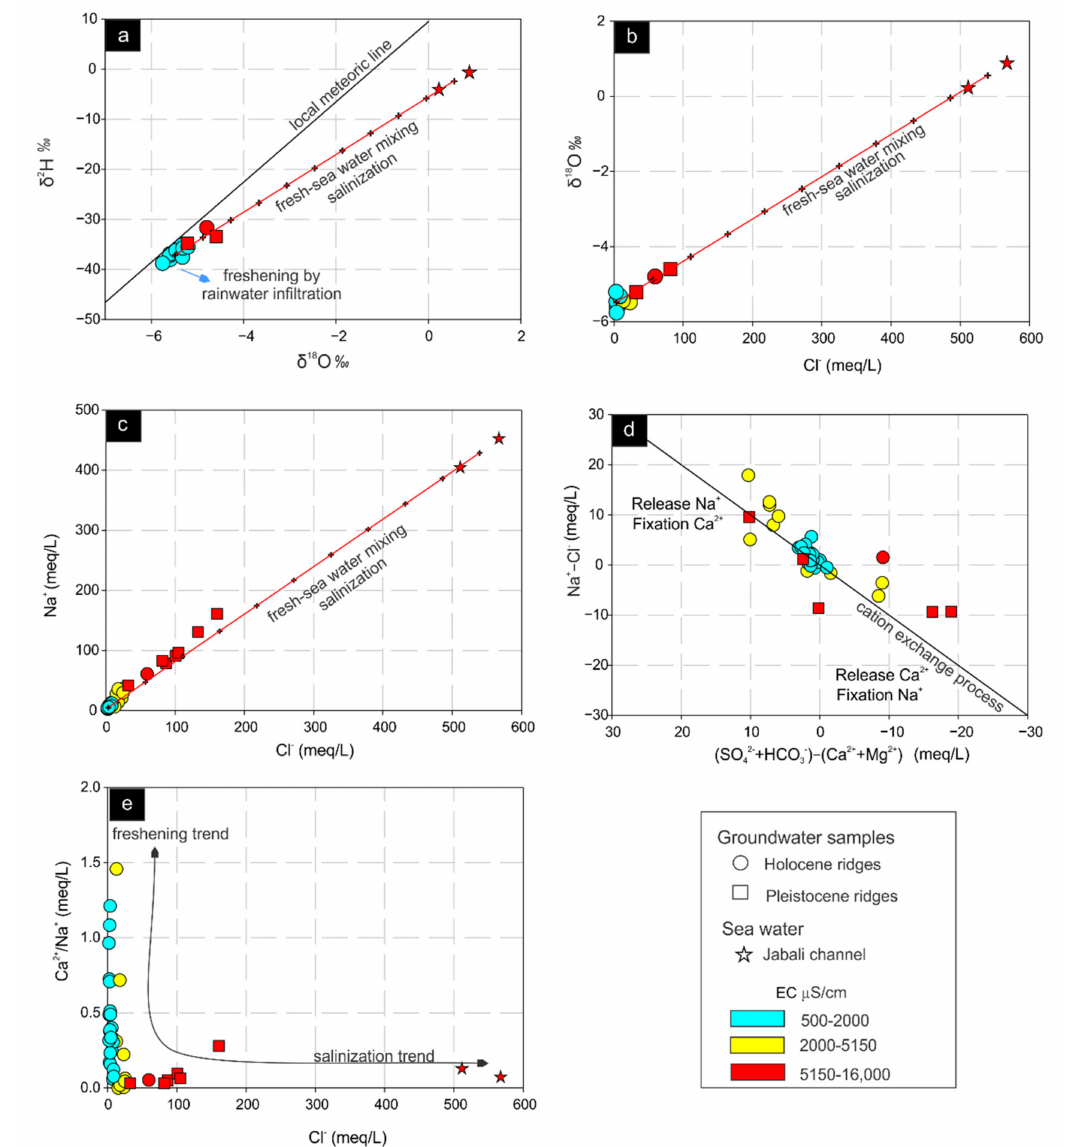
Figure 7. Stable isotope and ionic ratios of groundwater samples. ( a ) δ 2 H vs. δ 18 O, ( b ) δ 18 O vs. Cl − , ( c ) Na + vs. Cl − , ( d ) Na + − Cl − vs. (HCO 3 − + SO 4 2 − ) − (Ca 2+ + Mg 2+ ), ( e ) Ca 2+ /Na + vs. Cl −